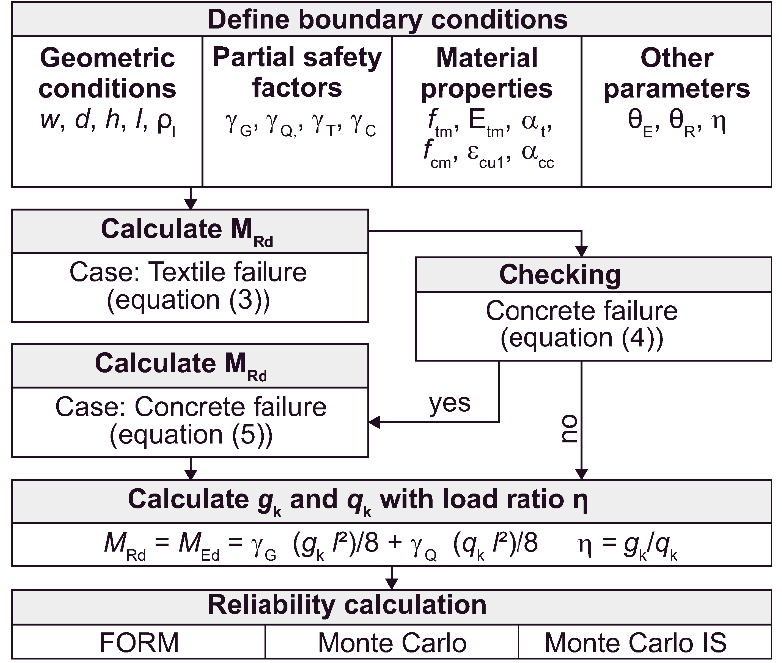
Figure 4. Flowchart for the calculation of M Rd and M Ed under the assumption of a linear σ–ε diagram for the concrete.